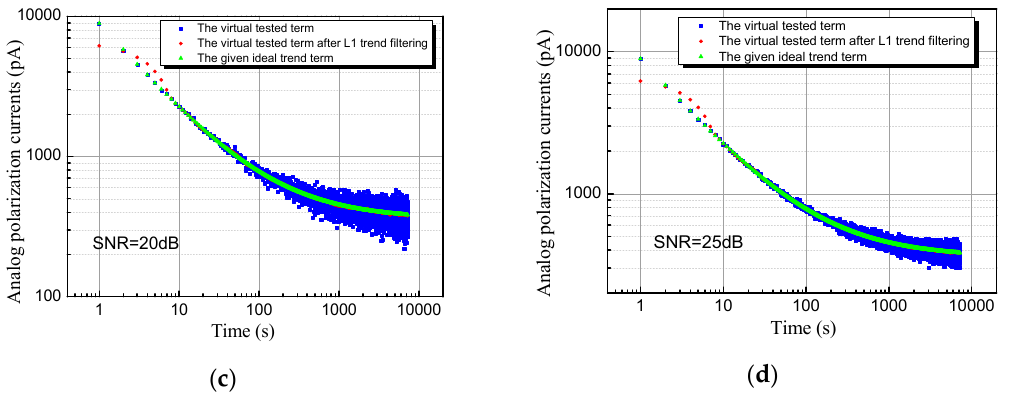
Figure 8. The effect diagram of L1 trend filtering for different degrees of noises with the ideal trend term produced by the Curie formula: ( a ) SNR = 10 dB; ( b ) SNR = 15 dB; ( c ) SNR = 20 dB; ( d ) SNR = 25 dB.